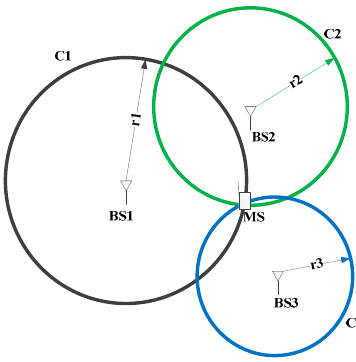
Figure 1. The MS location estimation based on the ideal TOA trilateration in the general case.